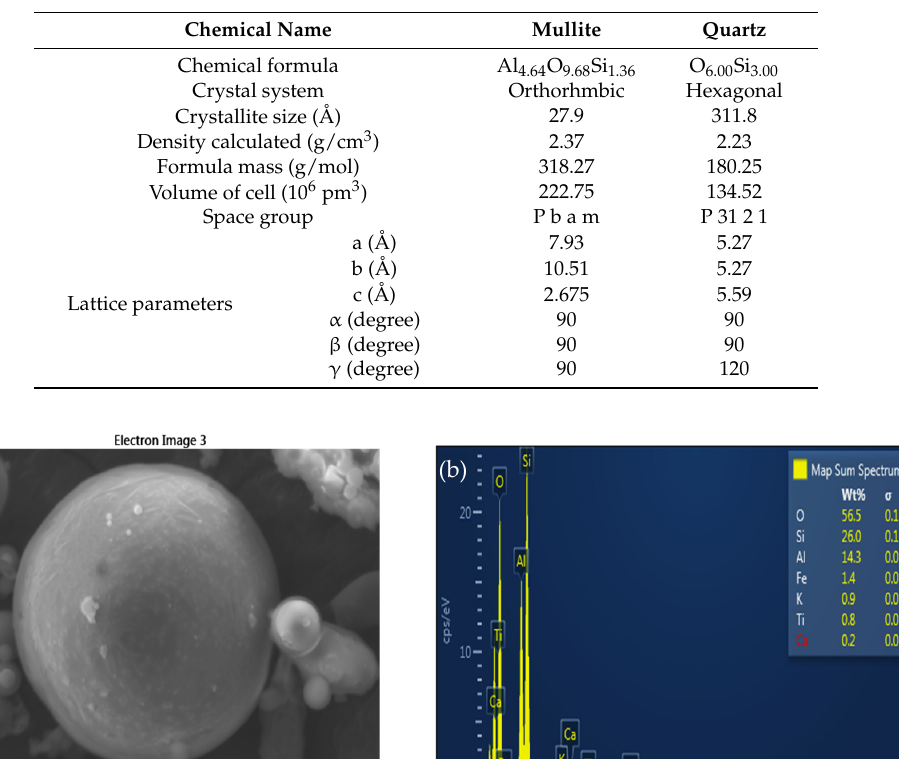
Table 3. Relevant parameters of fly ash from XRD.